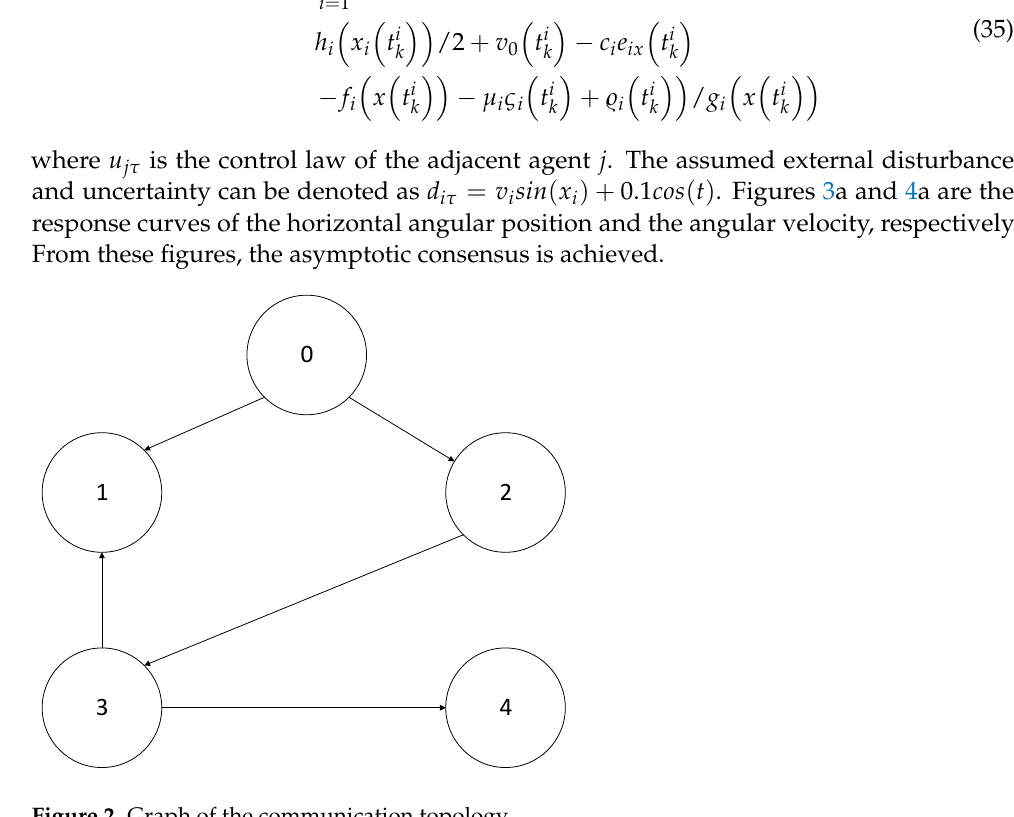
Figure 2. Graph of the communication topology.